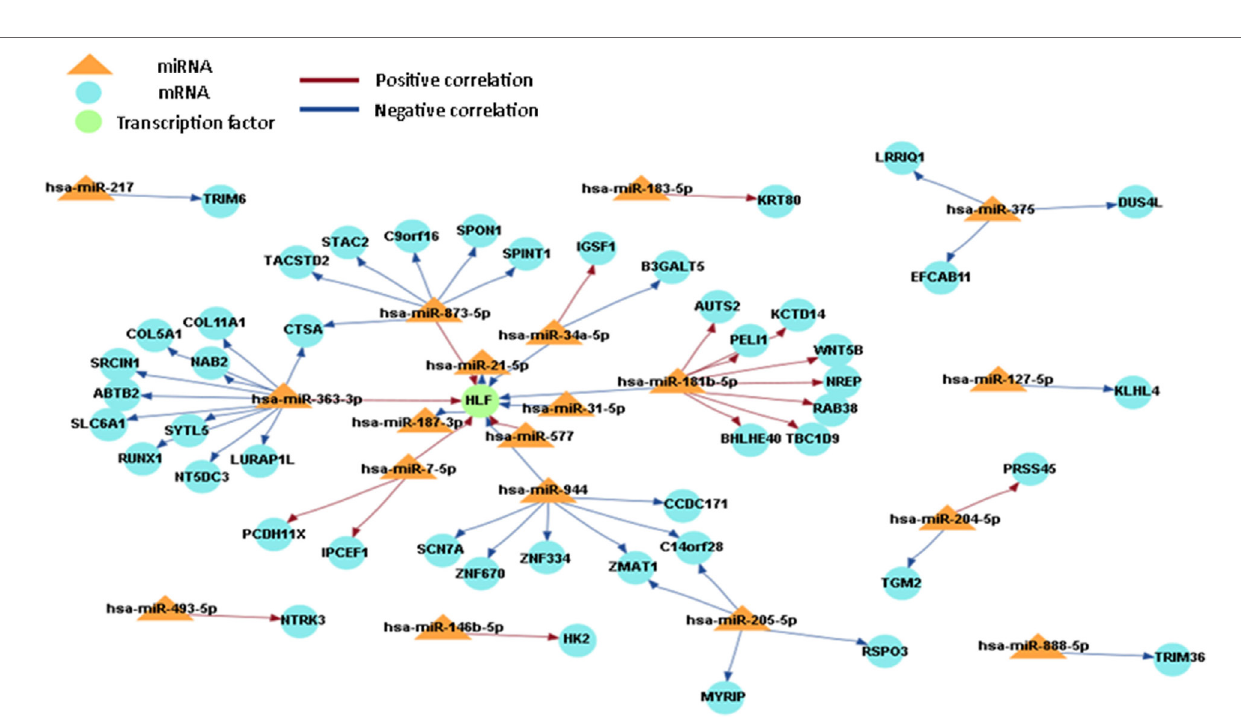
Frontiers in Endocrinology |